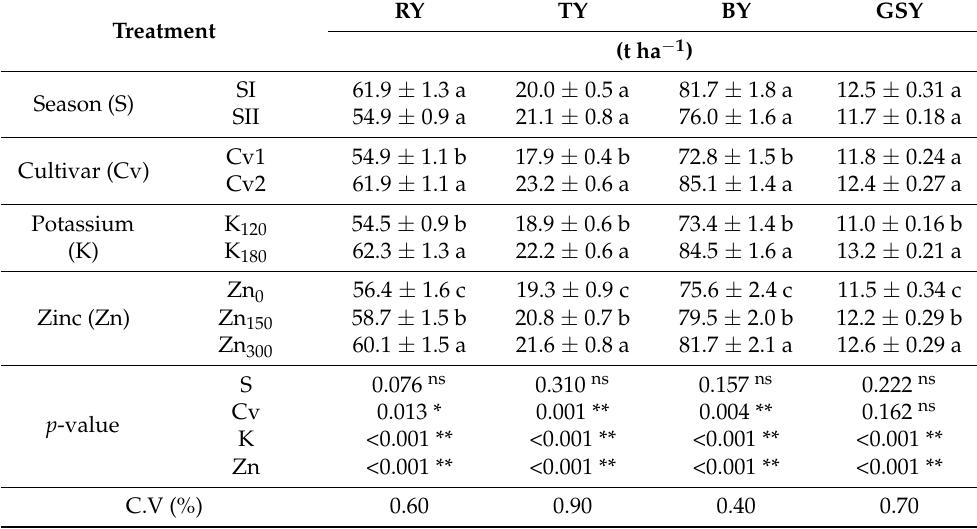
Table 6. Productivity (root yield (RY), top yield (RY), biological yield (BY), and gross sugar yield (GSY)) of two sugar beet cultivars (e.g., Kawemira (Cv1) and BTS 301 (Cv2)) affected by soil fertil- ization with two potassium levels (e.g., 120 (K 120 ) and 180 kg ha − 1 (K 180 )) and foliar application with three zinc levels (e.g., 0 (Zn 0 ), 150 (Zn 150 ), and 300 ppm (Zn 300 )) when grown under saline soil (EC e = 8.60 dS m − 1 ) conditions (data pooled over both